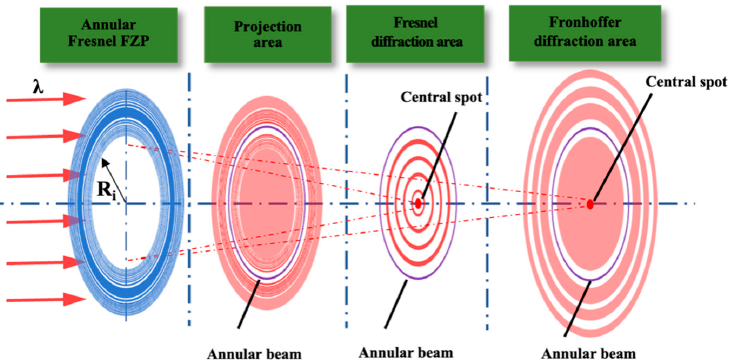
Figure 2. After the laser passes through the circular hole of the AFZP, it successively passes through the projection area, Fresnel diffraction area, and Fraunhofer diffraction area. The approximate range of the Fresnel diffraction area and the Fraunhofer diffraction area produced on the Z -axis can be deduced according to the Fresnel diffraction formula. When the radius of the circular hole is R i , the impulse response function of the light wave field is